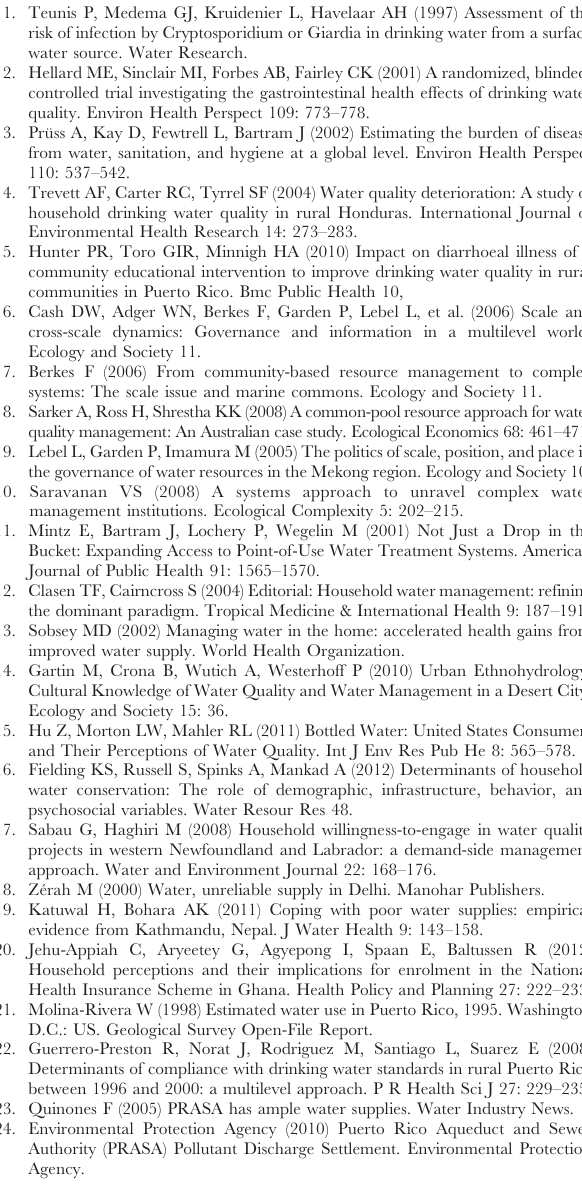
do not provide specific names of the communities or sectors surveyed in order to keep anonymity of our